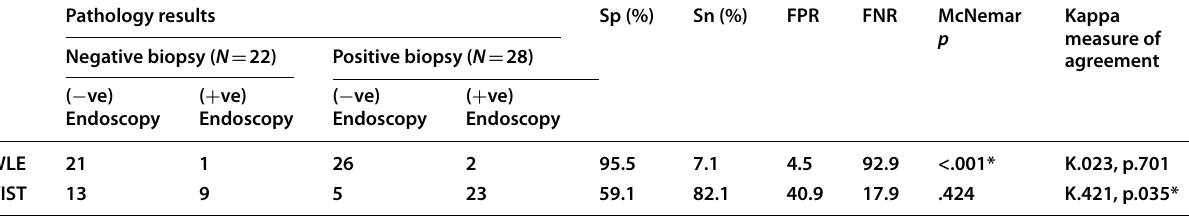
McNemar test for comparing proportion between VIST and pathology results WLE white light endoscopy, VIST Versatile Intelligent Staining Technology, Sp specificity, Sn sensitivity, FPR false positive rate, FNR false negative rate, K Kappa Measure of agreement, *: statistically significant where p value ≤